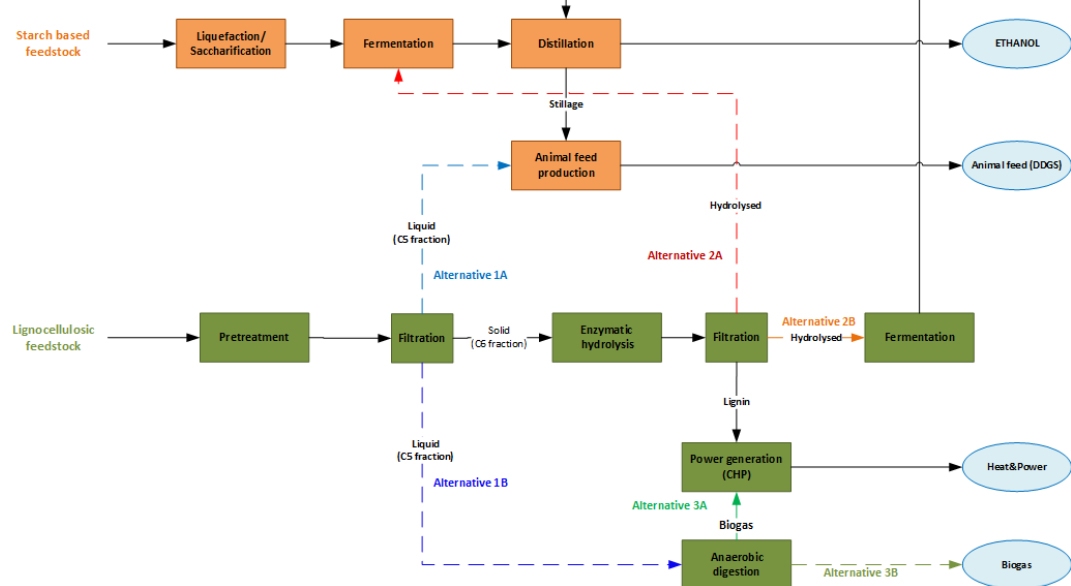
Figure 5. Possible configurations for the retrofitting of a starch-based 1G facility.